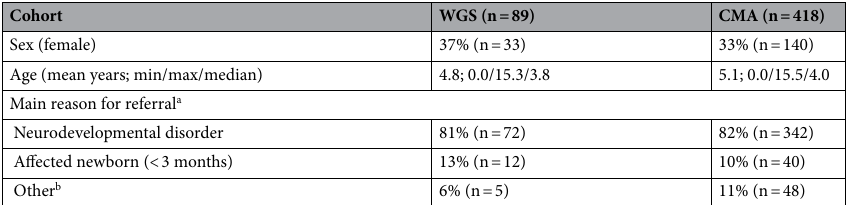
Table 1. Cohort characteristics at time of referral. a Twelve newborns in cohort CMA showed developmental